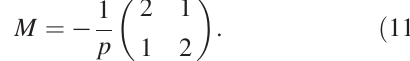
ffiffiffi p 3 . Using the formula